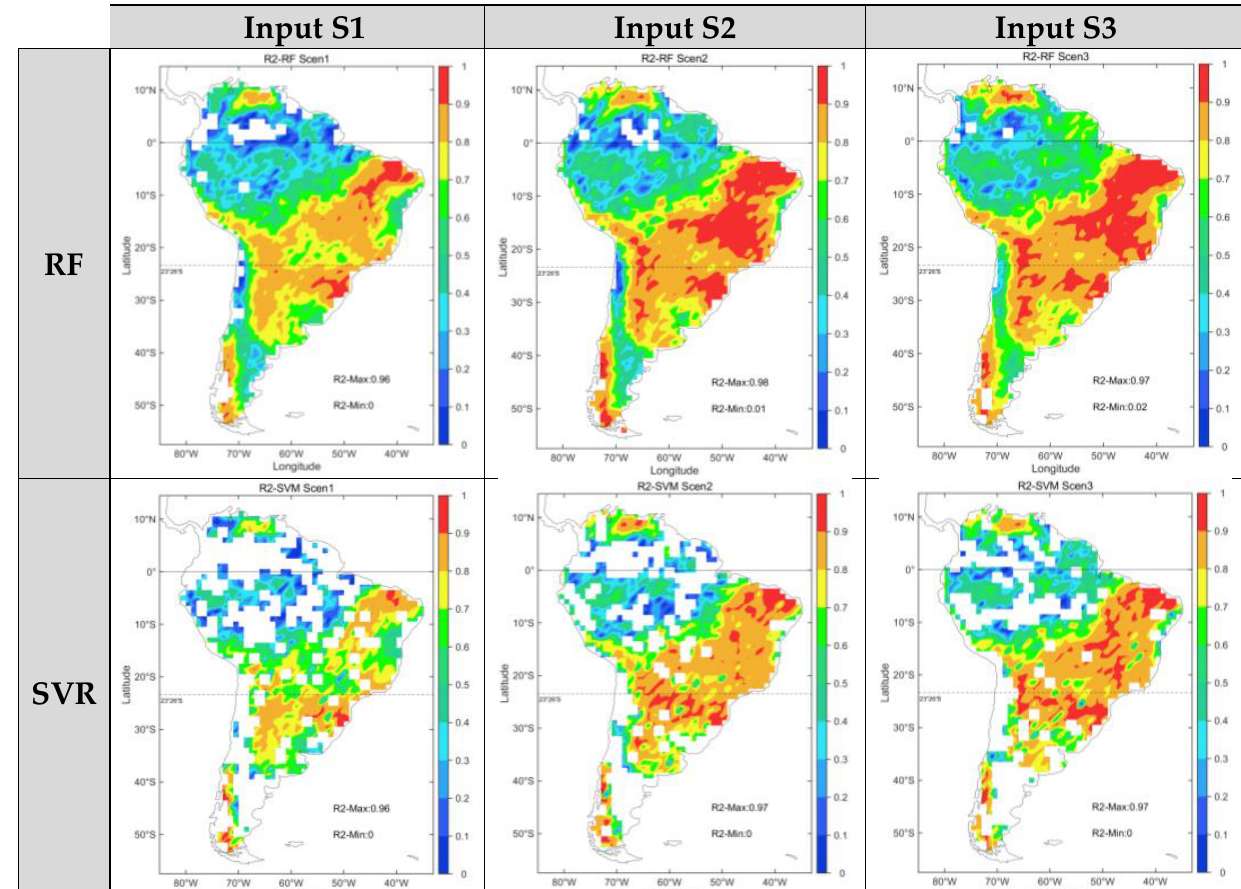
Figure 9. Distribution of the simulation accuracy 𝑅 2 of two models under different input strategies.